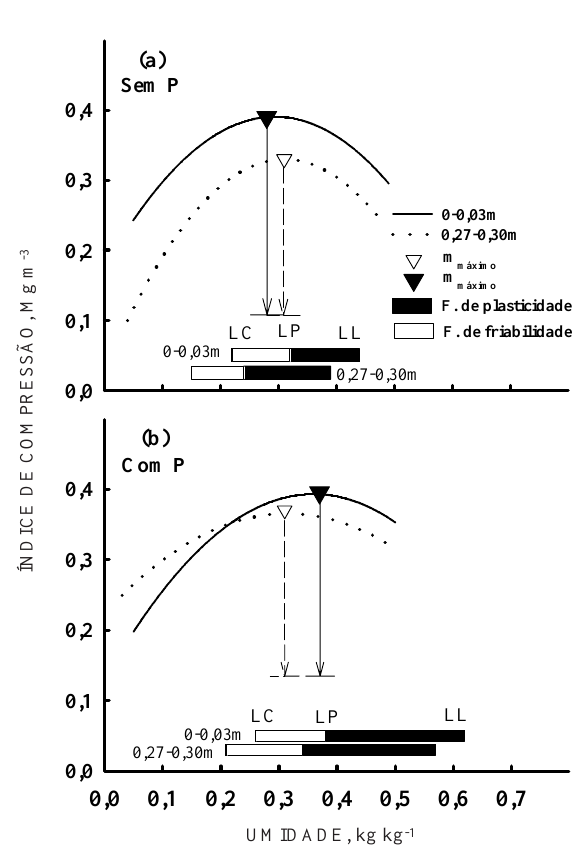
Figura 2. Índice de compressão (m) em função da umidade (U), nas condições com e sem P, nas camadas de 0-0,03 e 0,27-0,30 m de um